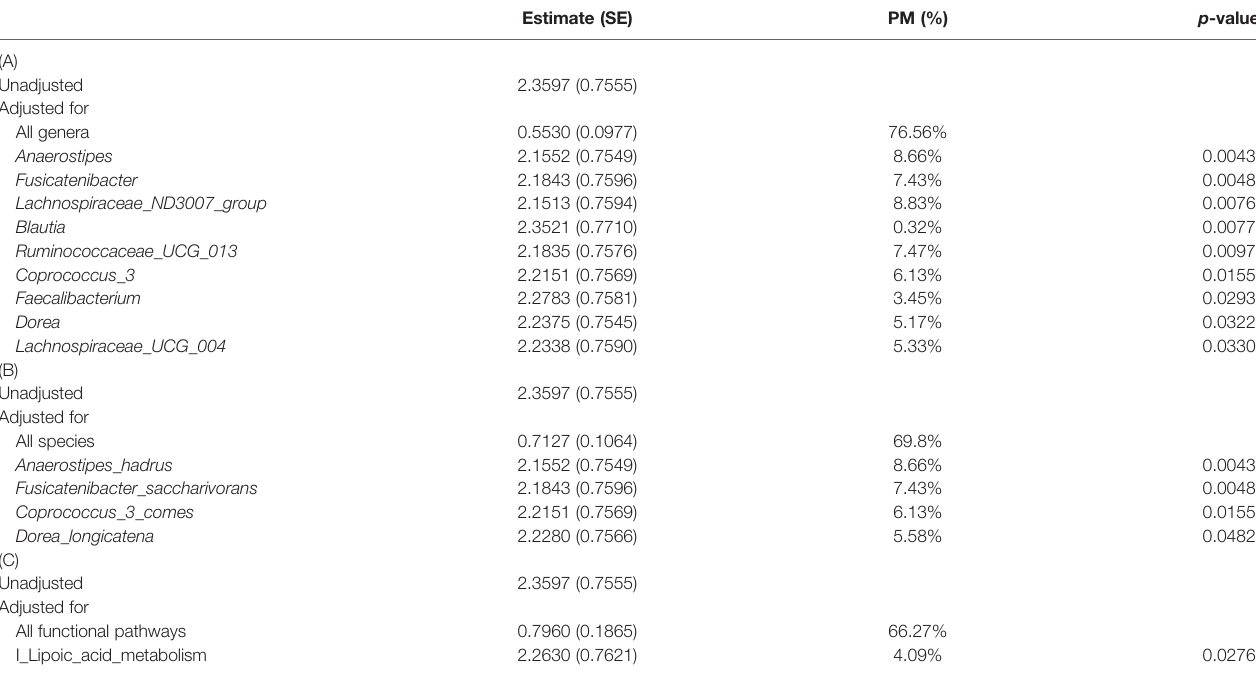
TABLE 2 | Mediation analysis for the mechanism of constipation inducing PD mediated by intestinal microbial alteration with different measures as mediators: (A) genus level, (B) species level, and (C) functional pathway level. Estimate